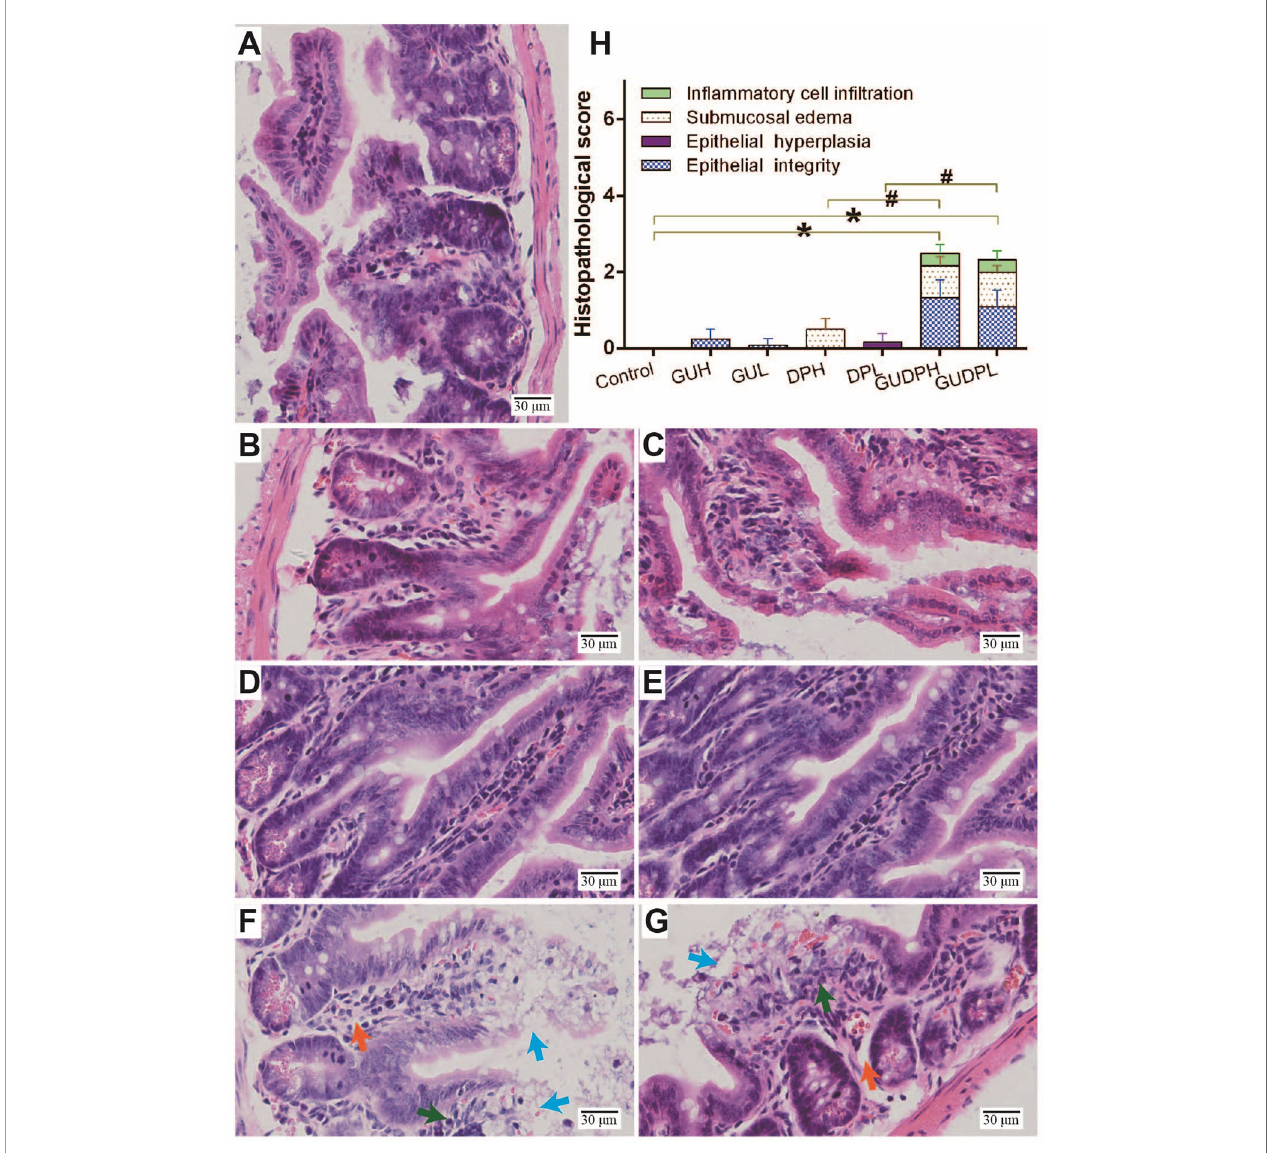
FIGURE 3 | Histopathological staining and evaluation of mouse ileum. HE staining of mouse ileum tissues in each group: (A) Control, (B) GUH, (C) GUL, (D) DPH, (E) DPL, (F) GUDPH, and (G) GUDPL groups. Blue arrows are signs of epithelial integrity loss, orange arrows are signs of submucosal edema, and green arrows are signs of in fl ammation cell in fi ltration. (H) Bar chart of histopathological scores of ileum tissues in each group. * P < 0.05 compared with control group, # P < 0.05 compared between herbal pair and single herb, as indicated by connecting